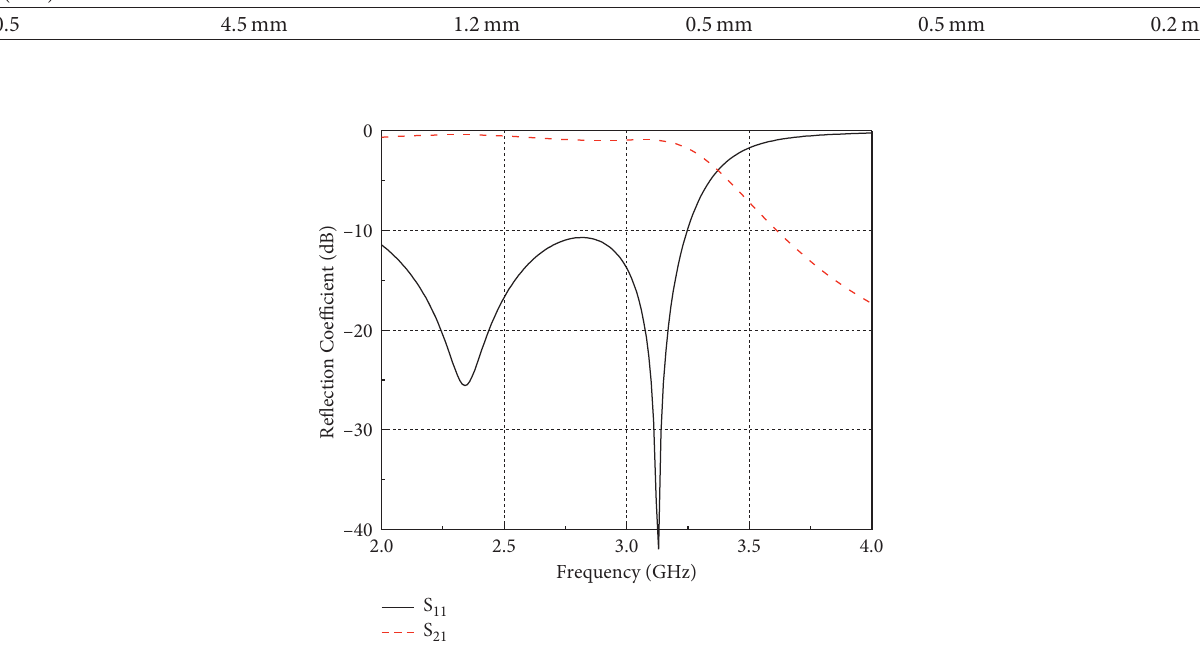
Figure 2: Simulated S parameters of the proposed LHM unit.